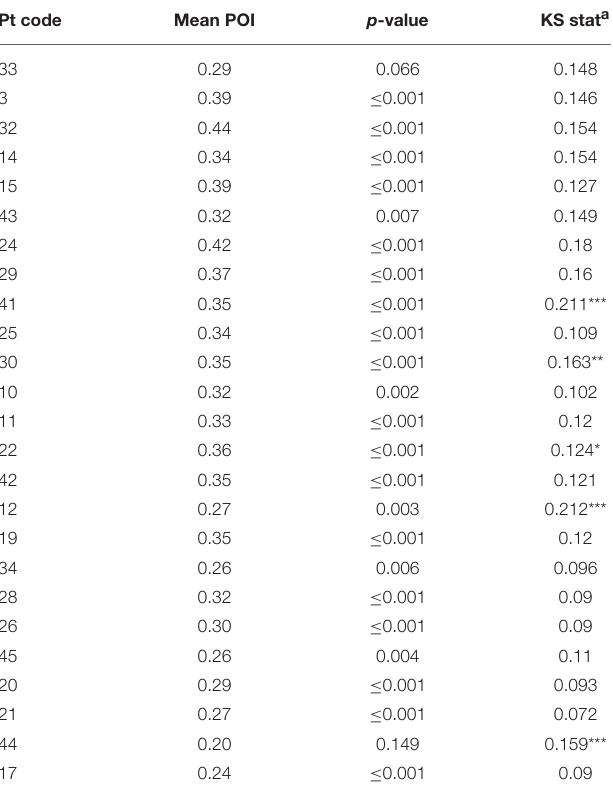
TABLE 3 | Test statistics for Phonological Overlap Index (POI) and distribution